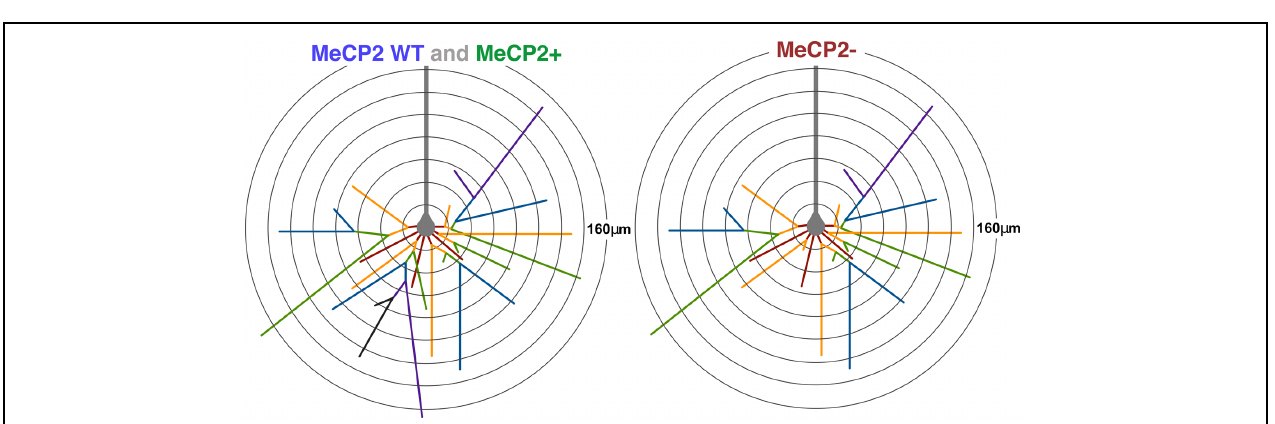
populations in heterozygous brains each have a smaller proportion of large cells than the population of MeCP2 WT cells. The MeCP2 − cell population also has fewer large cells than the MeCP2 + population in heterozygous brains. (total cells assessed MeCP2 WT, n = 761 neurons; MeCP2 + , n = 482; MeCP2 − n = 502). * p < 0.05 and ** p < 0.01.